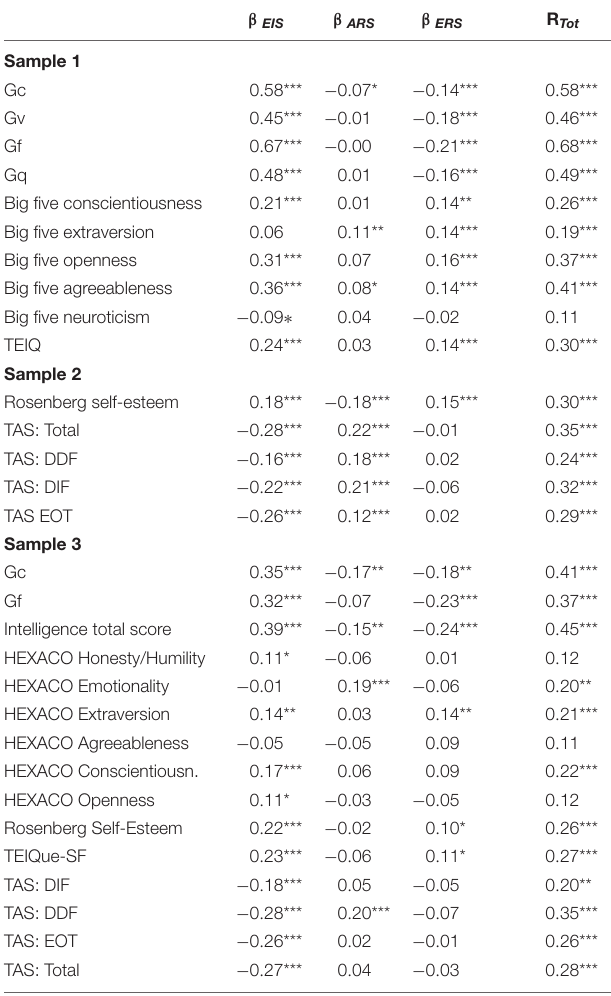
Regression analyses were executed with the variables in the nomological network as criteria and Emotional Intelligence Scores (EIS), Acquiescent Responding Scores (ARS), and Extremity Responding Scores (ERS) as predictors. R Tot represents the multiple correlation of Emotional Intelligence Scores, Acquiescent Responding Scores, and Extreme Responding Scores with each of the variables in the nomological network. DIF: Difficulty Identifying Feelings, DDT: Difficulty Describing Feelings, EOT: Externally Oriented Thinking. ***p < 0.001, **p < 0.01, *p < 0.05.